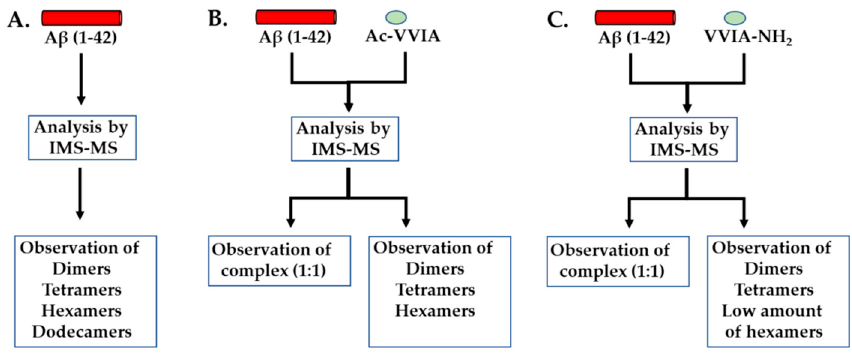
Figure 4. Schematic representation of the ion mobility spectrometry-mass spectrometry experiments performed for the investigation of A β (1–42) oligomerization in the absence ( A ) or presence of the tetrapeptides Ac-VVIA ( B ) and VVIA-NH2 ( C ).